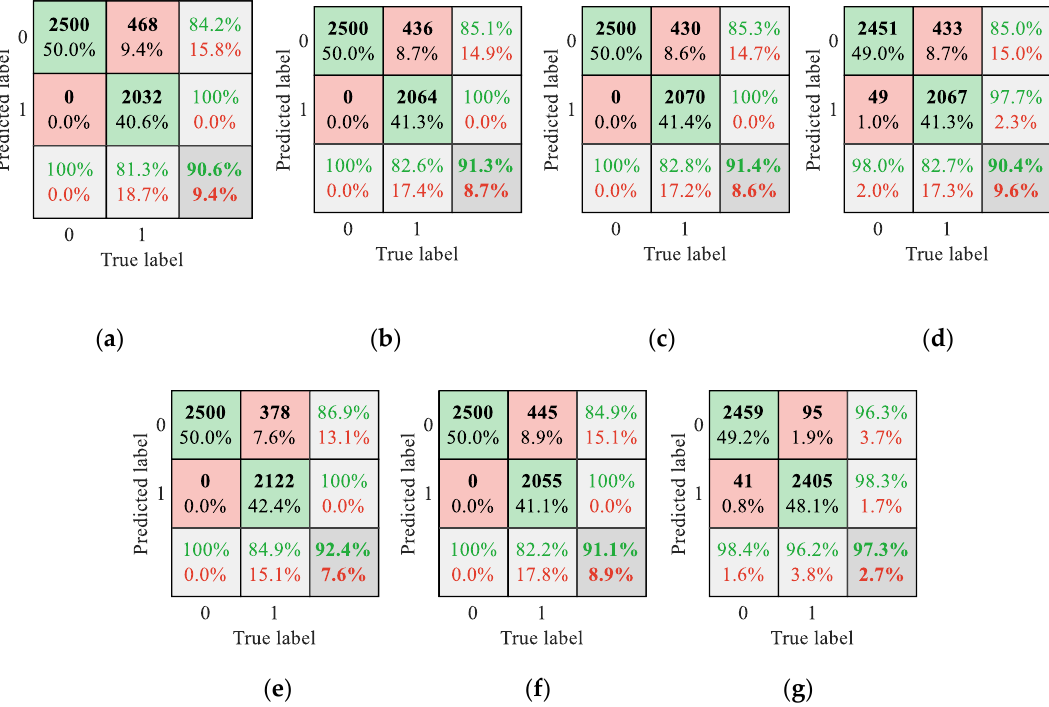
Figure 5. Confusion matrix results of different methods. ( a ) standard CDBN; ( b ) single-scale temporal CDBN (STCDBN); ( c ) single-scale spatial CDBN (SSCDBN); ( d ) single-scale spatio-temporal CDBN (SSTCDBN); ( e ) multiscale temporal CDBN (MTCDBN); ( f ) multiscale spatial CDBN (MSCDBN); and ( g ) proposed method.